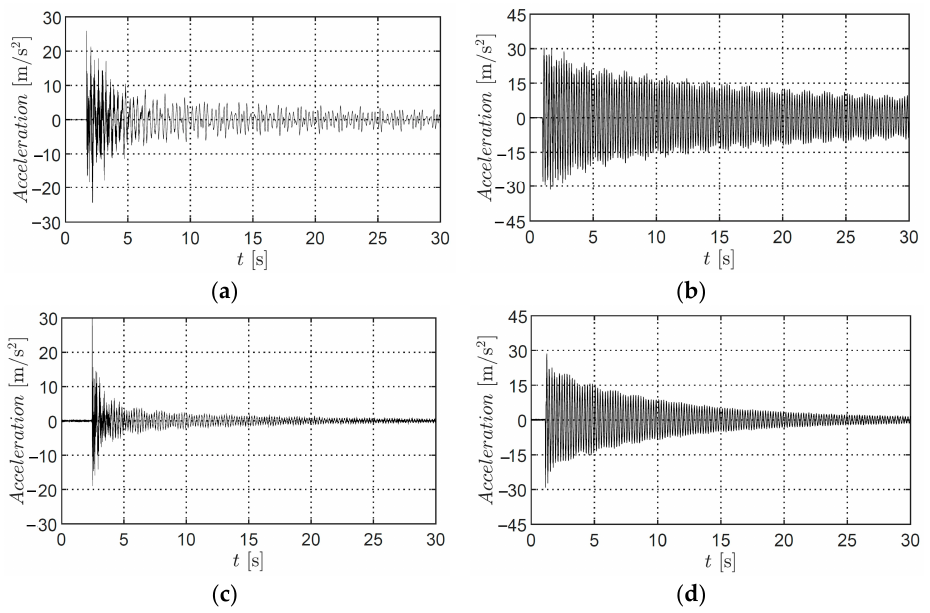
Figure 17. Dominant coupled responses from Setup 2: ( a ) vertical response at U = 0 m/s; ( b ) vertical response at U = 10 m/s; ( c ) torsional response at U = 0 m/s; ( d ) torsional response at U = 10 m/s.